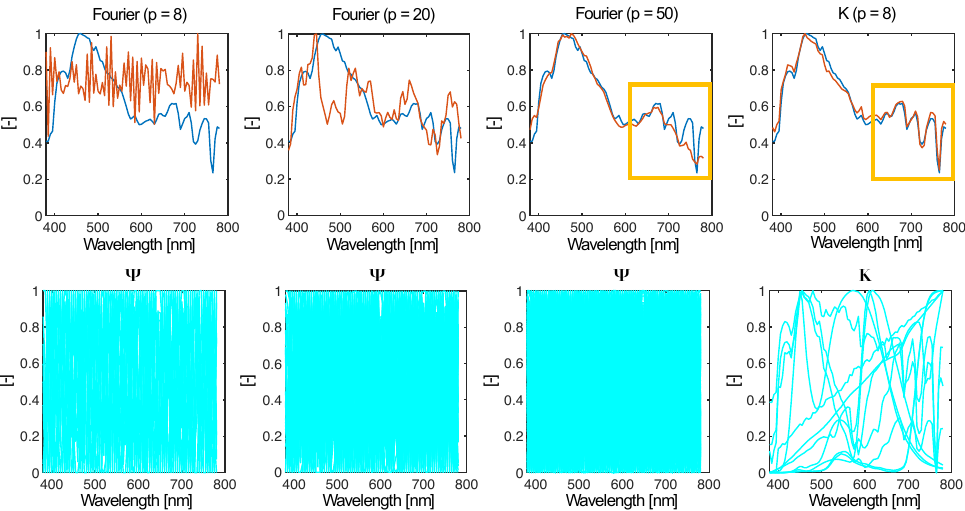
Figure 2. The advantage of using a data-driven basis to solve the tailored sensing problem over classical compressed sensing illustrated in the reconstruction of a spectral power distribution sampled at different rates. Although the tailored library K contains fewer modes, enough shared features enable high-performance reconstruction, compared with generic Fourier modes (especially as seen in recovering the structure in the highlighted